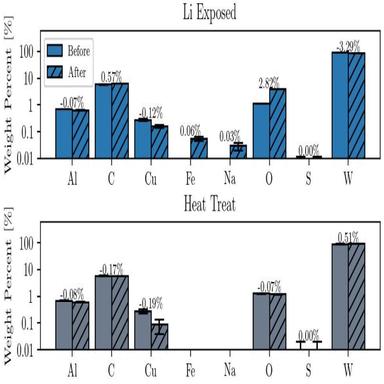
EDS of the tungsten sample, showing average surface composition, obtained from EDS analysis at 500X magnification for lithium-exposed samples (blue) and heat-treated sample (gray). Some pickup of Fe is evident and is expected to have come from the stainless-steel vessel. Oxygen has increased on the surface, likely due to the formation of lithium-oxide. The tungsten concentration has gone down with the increase in these other elements. Error bars represent the standard deviation in composition and the numbe